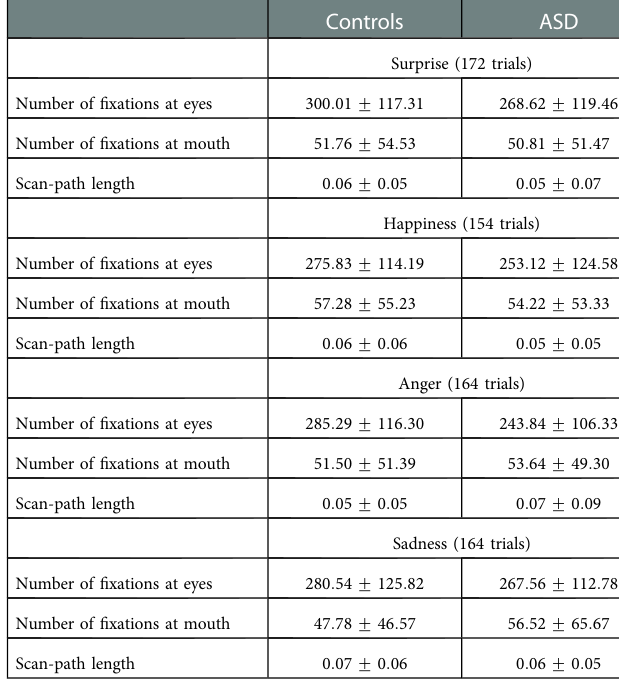
Controls ASD Surprise (172